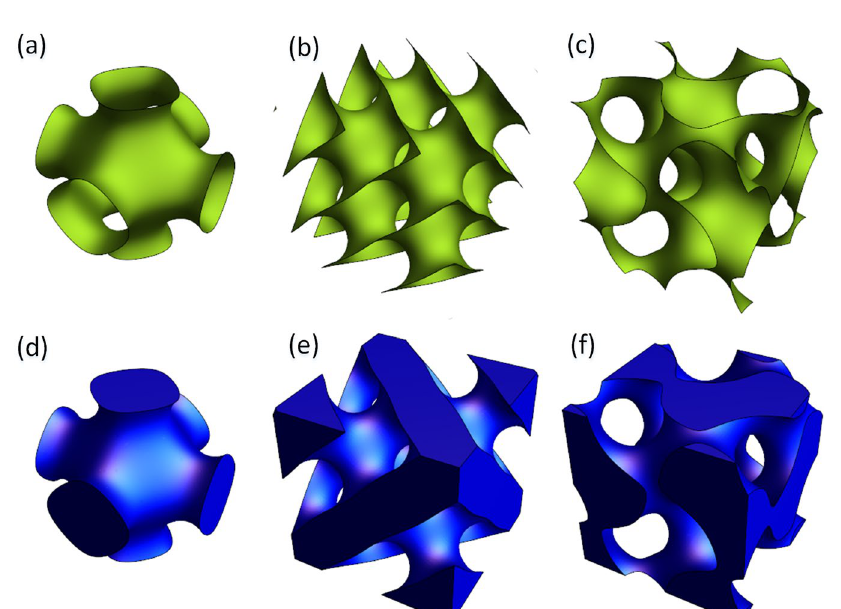
Figure 6. Triangulation of a non-closed implicit surface: ( a ) P surface, ( b ) D surface, ( c ) G surface; triangulation of typical closed implicit surface: ( d ) P surface, ( e ) D surface, ( f ) G